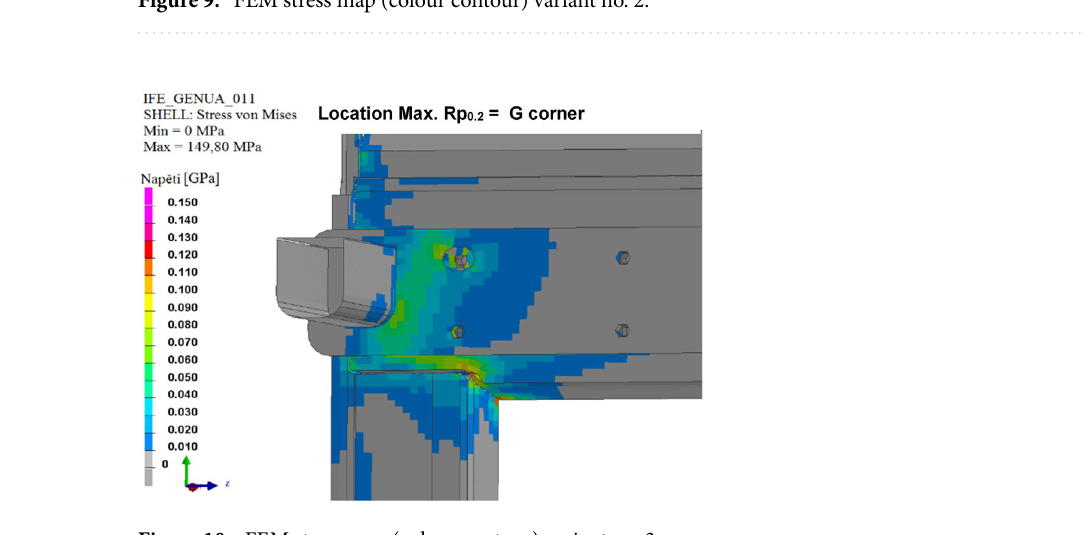
Figure 10. FEM stress map (colour contour) variant no. 3.